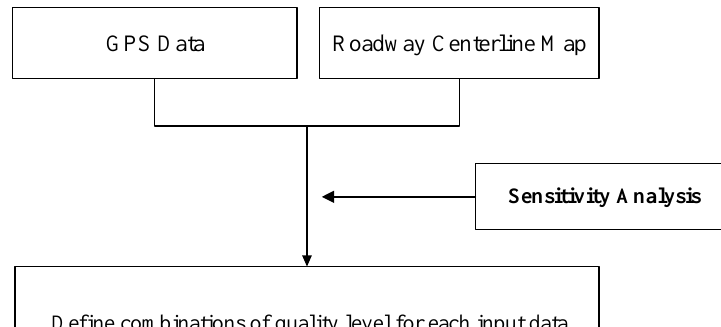
Figure 9. Overall procedure of uncertainty and sensitivity